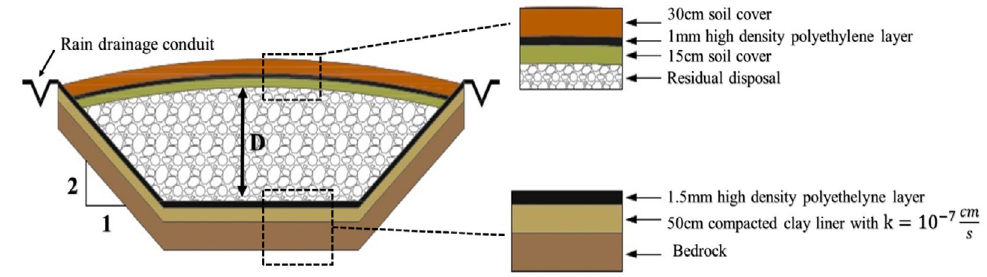
Fig. 3: Cross section of the final designed landfill